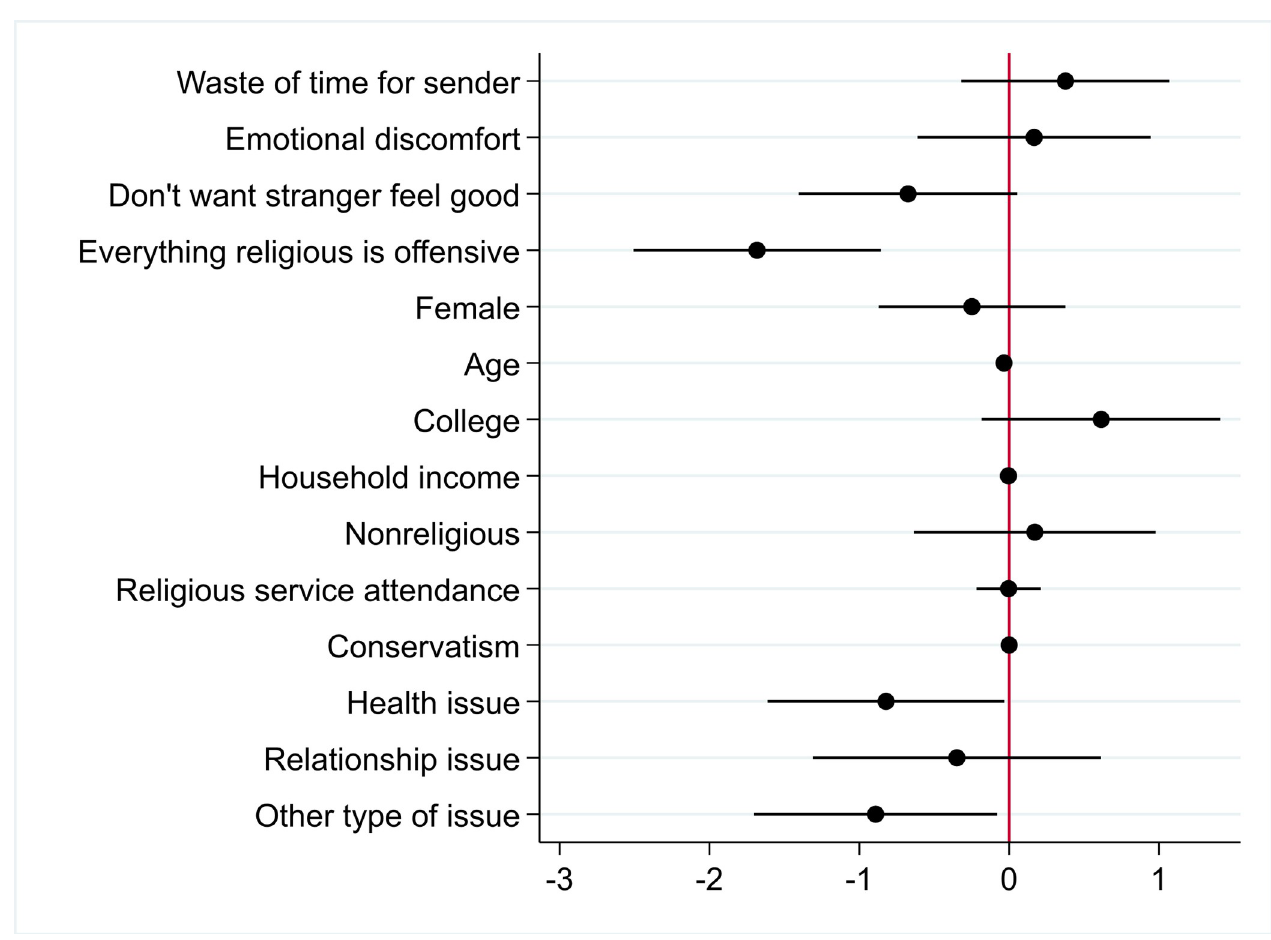
Fig 5. Determinants of the negative value of prayers. Note: Coefficients generated by Ordinary Least Squares regression, N = 211, R 2 = 0.205. Error bars represent 95% confidence intervals. A value of zero implies that the variable does not affect the average value of the negative WTP for a